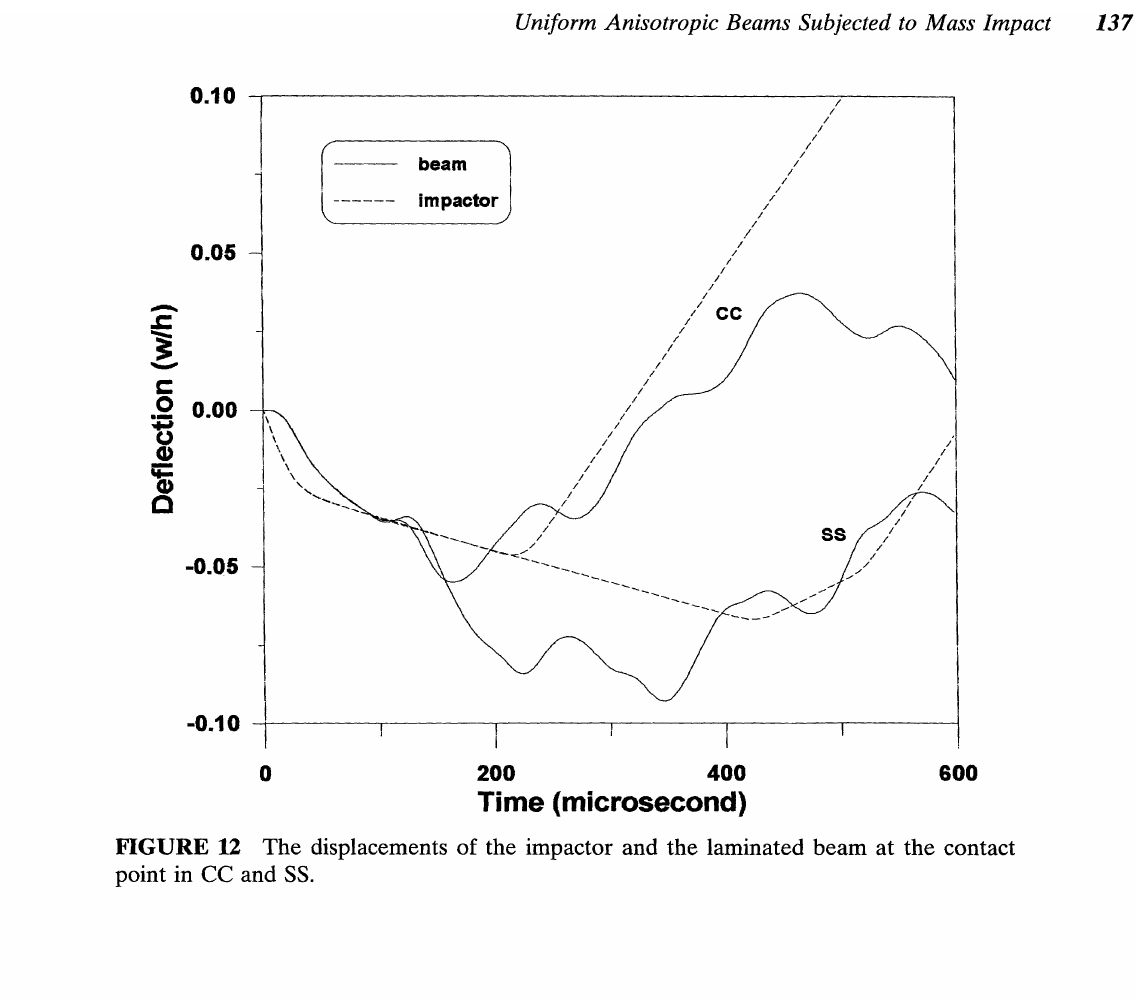
FIGURE 12 The displacements of the impactor and the laminated beam at the contact point in CC and